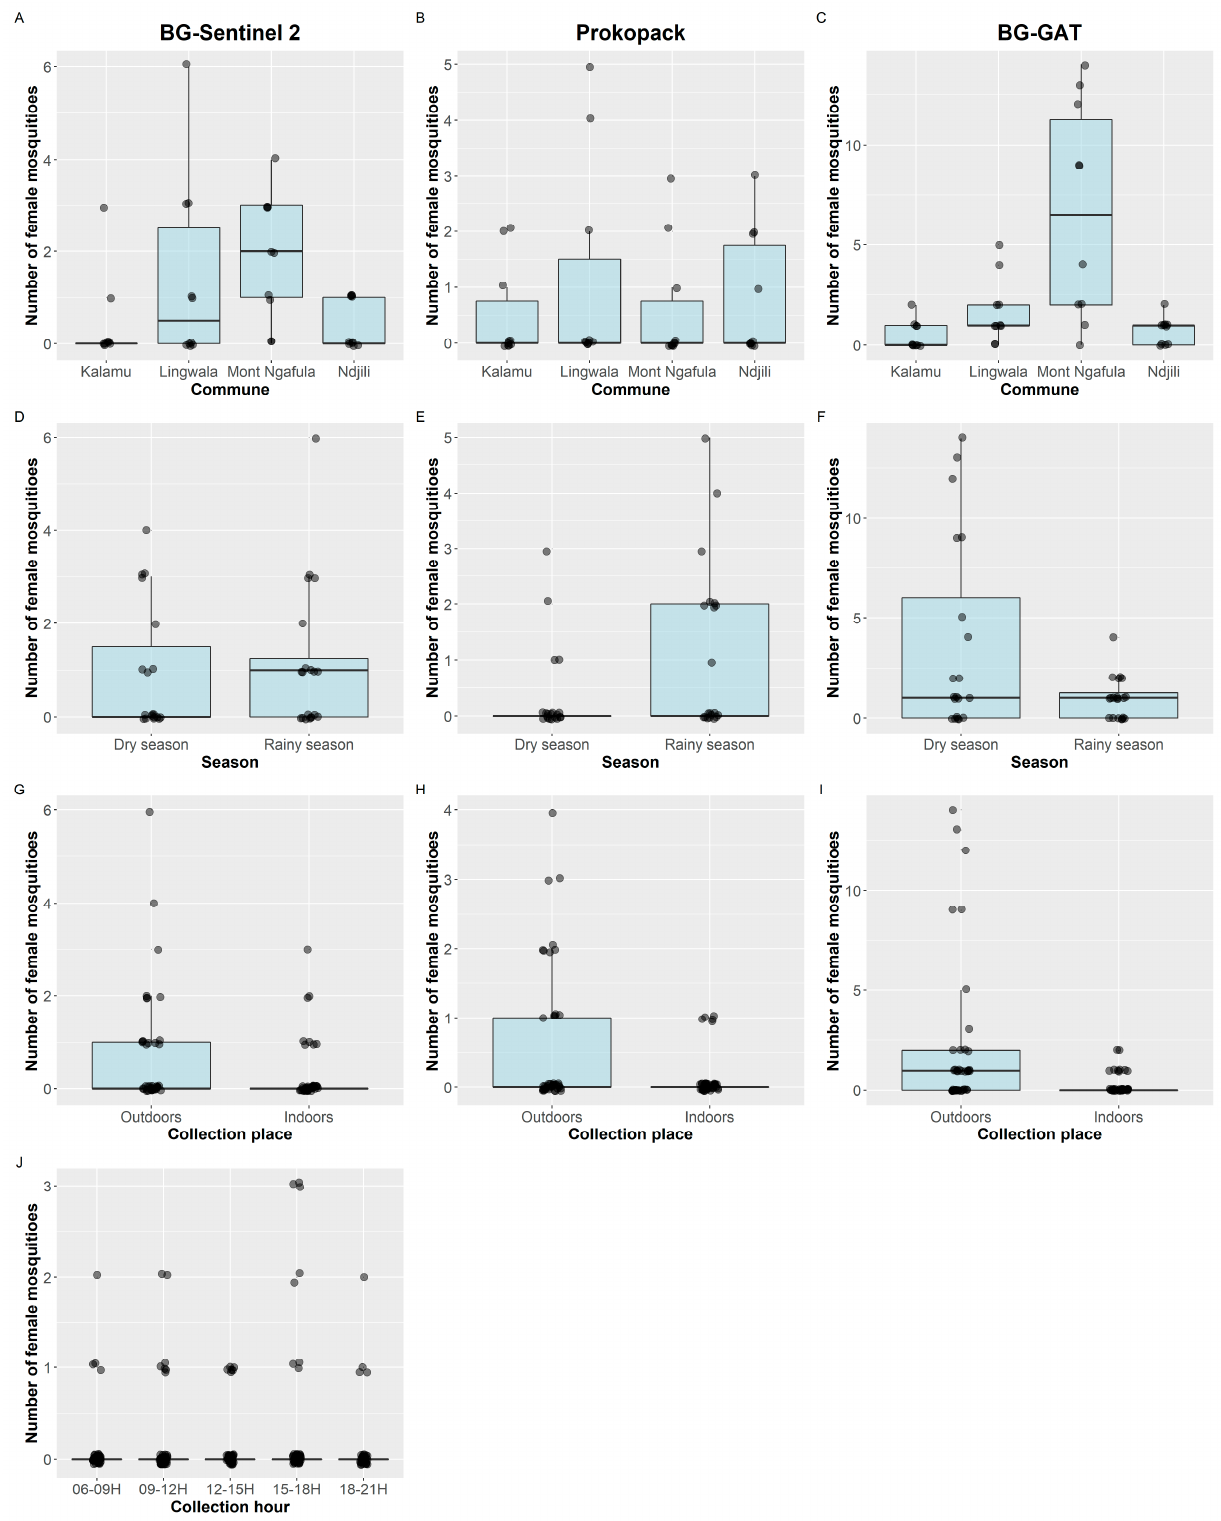
Figure 2. Number of female Aedes albopictus mosquitoes collected per day (dots), summarized by commune ( A – C ), season (collection surveys) ( D – F ), collection place ( G – I ), and collection time ( J ). The boxplots provide an overview of the medians and interquartile ranges. Column 1 provides data from the BG-Sentinel 2 collections, column 2 from the prokopack collections, and column 3 from the BG-GAT collections. Note. The scales of the y-axes are adjusted to the collections to enable interpretation of the